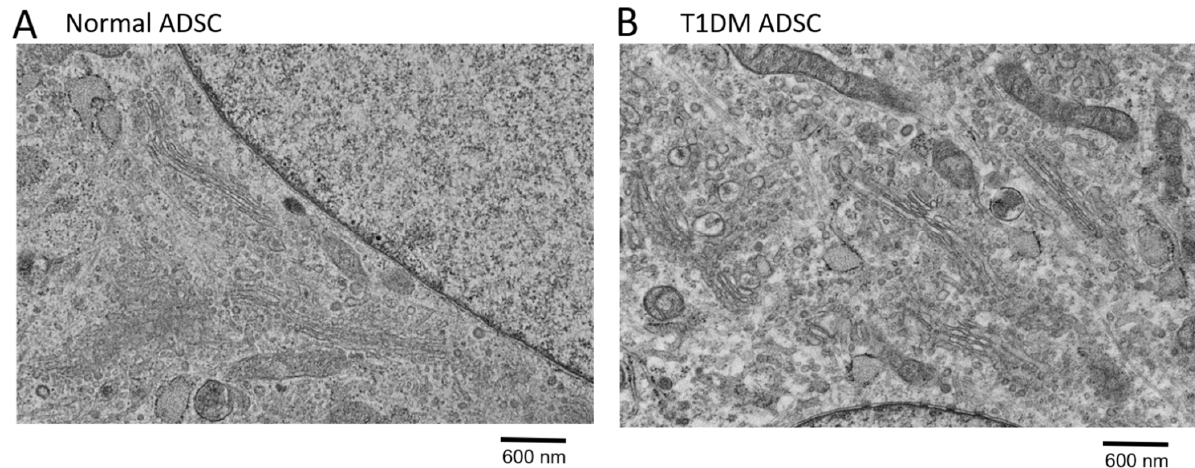
Figure 2. Electron microscopic images of the intracellular vesicles in adipose-derived mesenchymal stem cells (ADSCs). Transmission electron microscopic (TEM) images showing the morphology of the intracellular vesicles in ADSCs are shown. ( A ) An image of intracellular vesicles in normal ADSCs. ( B ) An image of intracellular vesicles in adipose-derived stem cells of patients with type 1 diabetes mellitus (T1DM ADSCs). The scale bar measures 600 nm.